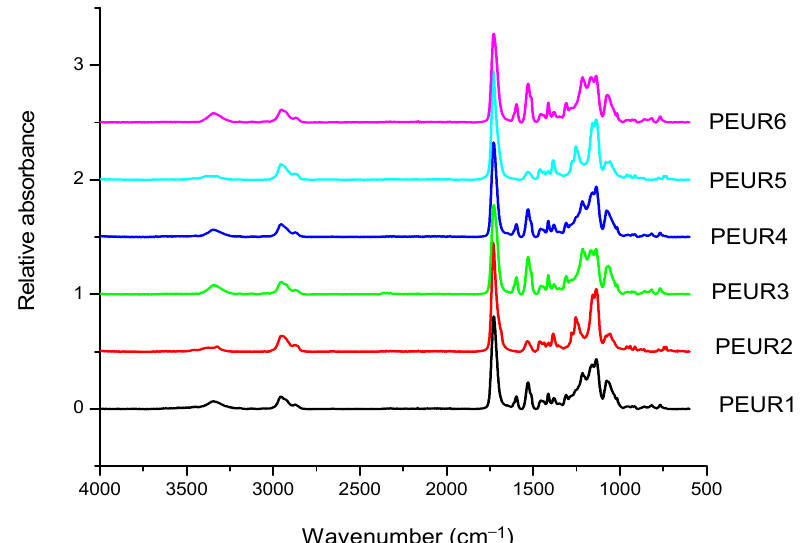
Figure 9. FTIR spectra of PEURs after thermal treatment 200 h at 130 °C.